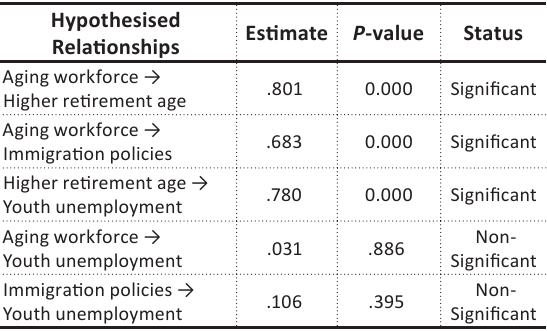
Table 4. Results for the direct relationships